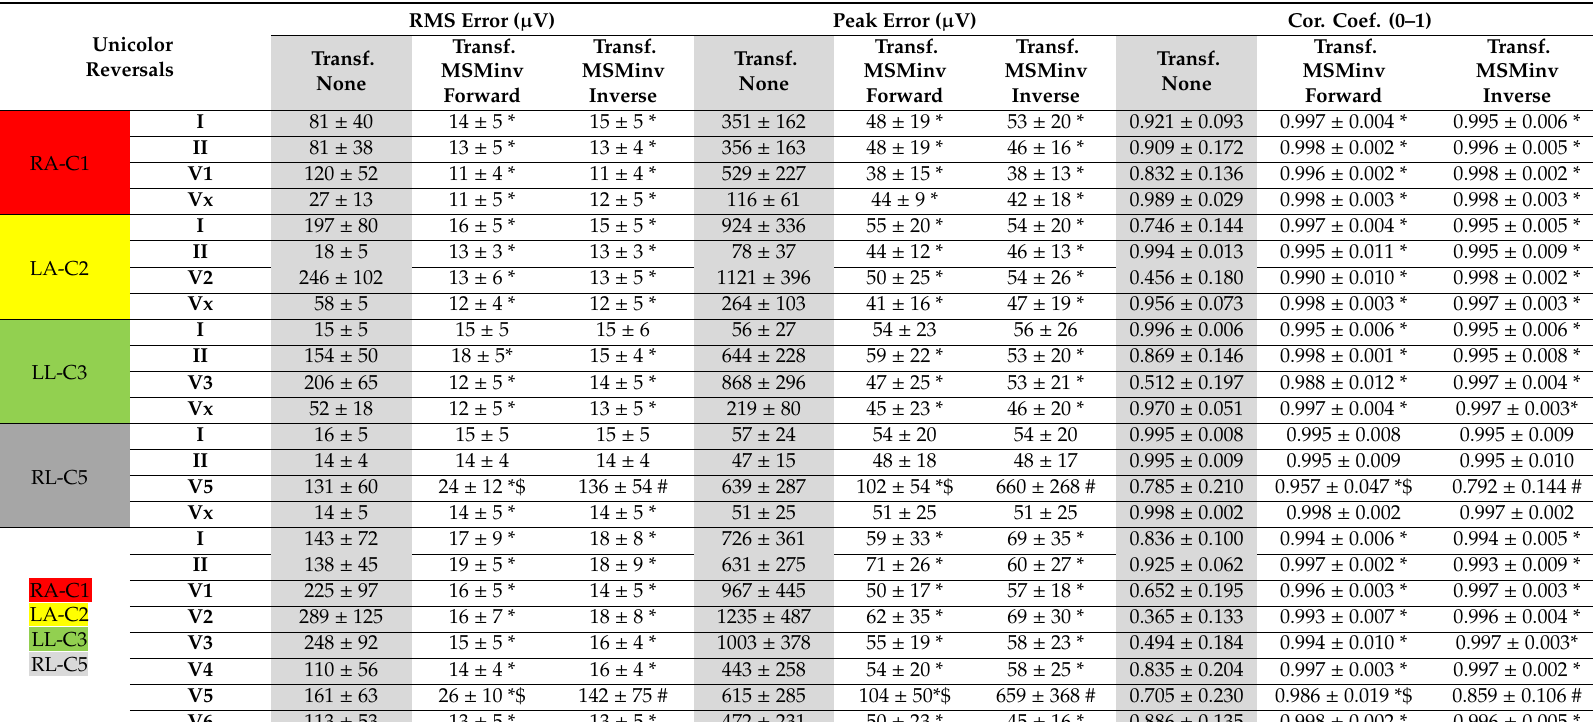
Table 5. Statistical analysis (mean value ± standard deviation) of measures (RMS Error, Peak Error, CorCoef) calculated for the average beat in 8 independent leads (I, II, V1-V6), quantifying the lead-specific di ff erences between experimentally recorded ECGs – raw leads vs. reordered leads (based on the expressions in Table 4) for 3 di ff erent scenarios:. No transformation; Forward ‘MSMinv’ transformation applied on the recording with correct electrodes; Inverse ‘MSMinv’ transformation applied on the recording with swapped